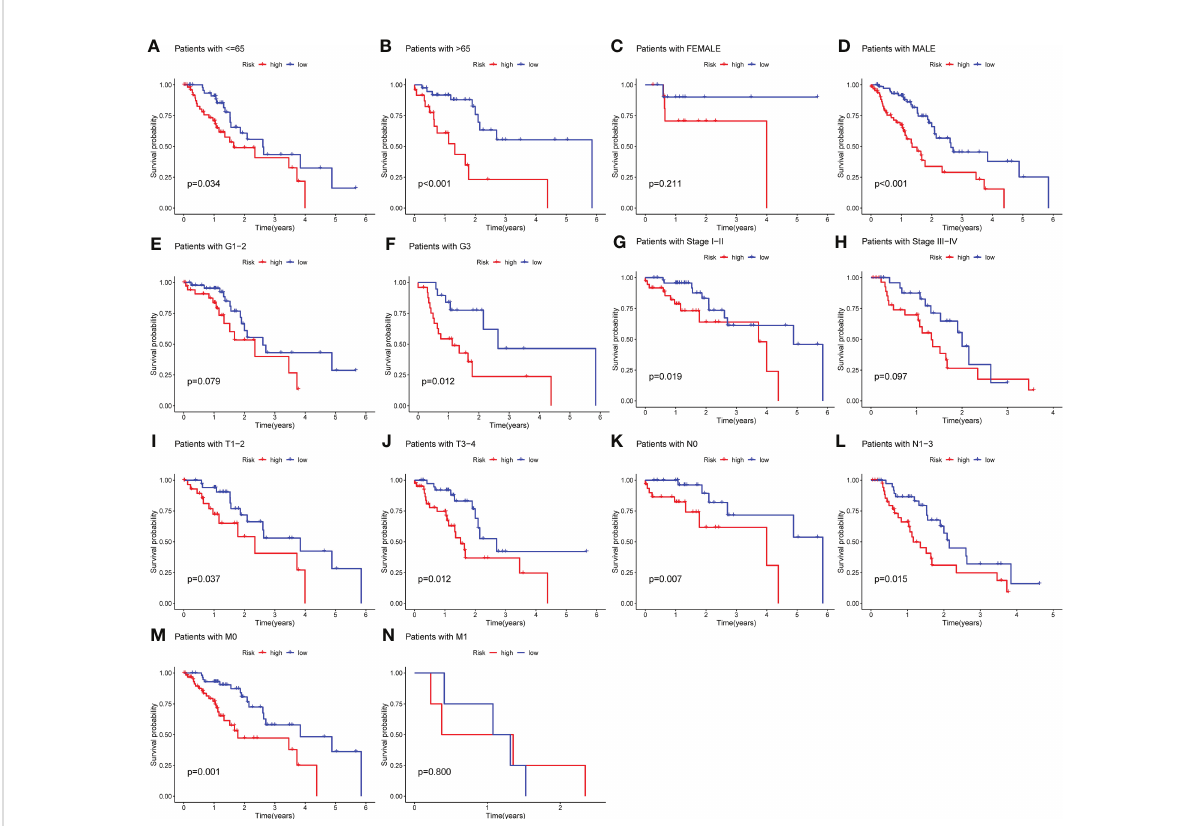
FIGURE 4 Strati fi cation analysis according to different clinicopathological characteristics. (A – N) Strati fi cation survival analysis was implemented on the basis of clinicopathological characteristics, including age (age ≤ 65 vs. age > 65), sex (male vs. female), grade (G1 – G2 vs. G3), stage (stages I – II vs. III – IV), stage T (T1 – T2 vs. T3 – T4), stage M (M0 vs. M1), and stage N (N0 vs. N1). K-M survival curves uncovered that for patients with the characteristics of age > 65, age ≤ 65, male sex, grade 3, stage I – II, T1-2, T3-4, N0, N1-3, and M0, there was a better OS among EC patients